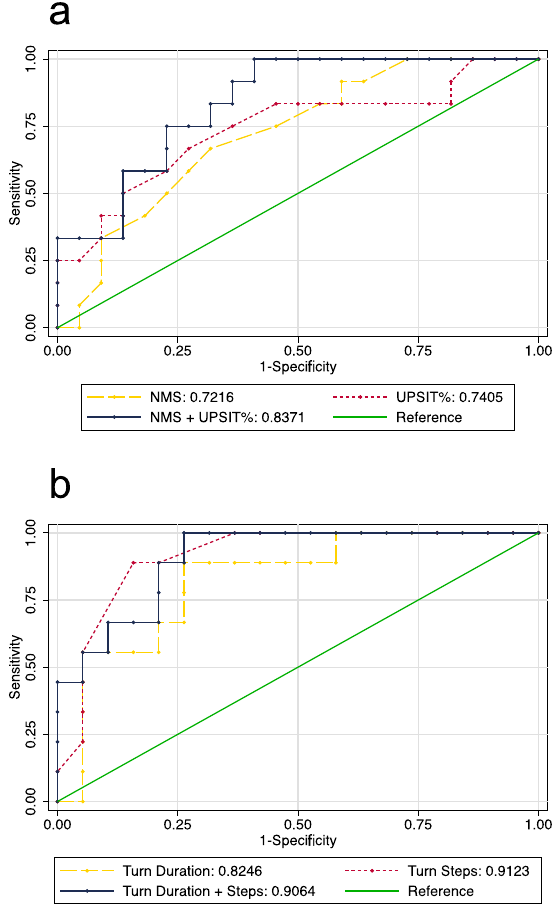
Fig. 1 ROC curves. Receiver operating characteristic (ROC) curves for clinical predictors of abnormal DAT-SPECT in DIP patients. Non- motor ROC curves include total score on the Non-Motor Symptoms Questionnaire (NMS), age- and sex-adjusted percentile score on the University of Pennsylvania Smell Identi fi cation Test (UPSIT%), and a combined measure of NMS total and UPSIT percentile scores ( a ). Motor ROC curves include turn duration, turn steps, and a combined measure of turn duration and steps using the instrumented Timed Up and Go (iTUG) ( b